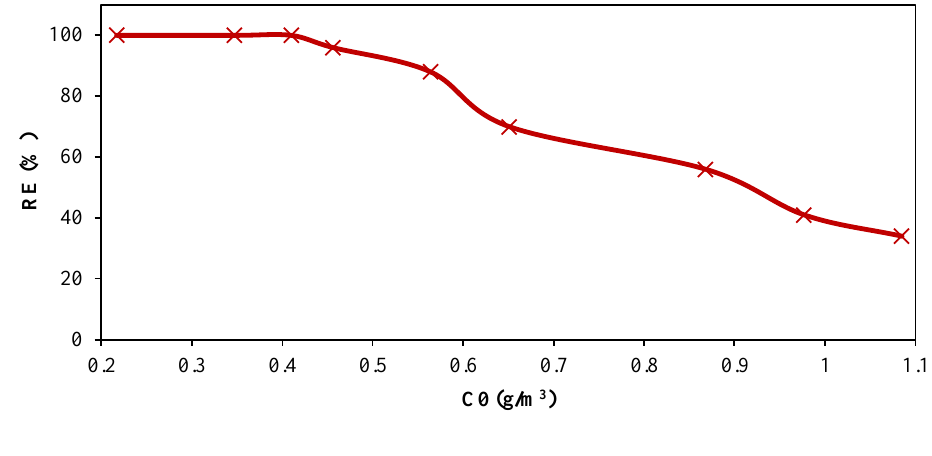
Figure 3. Effect of inlet concentration on removal efficiency at 1 min residence time.